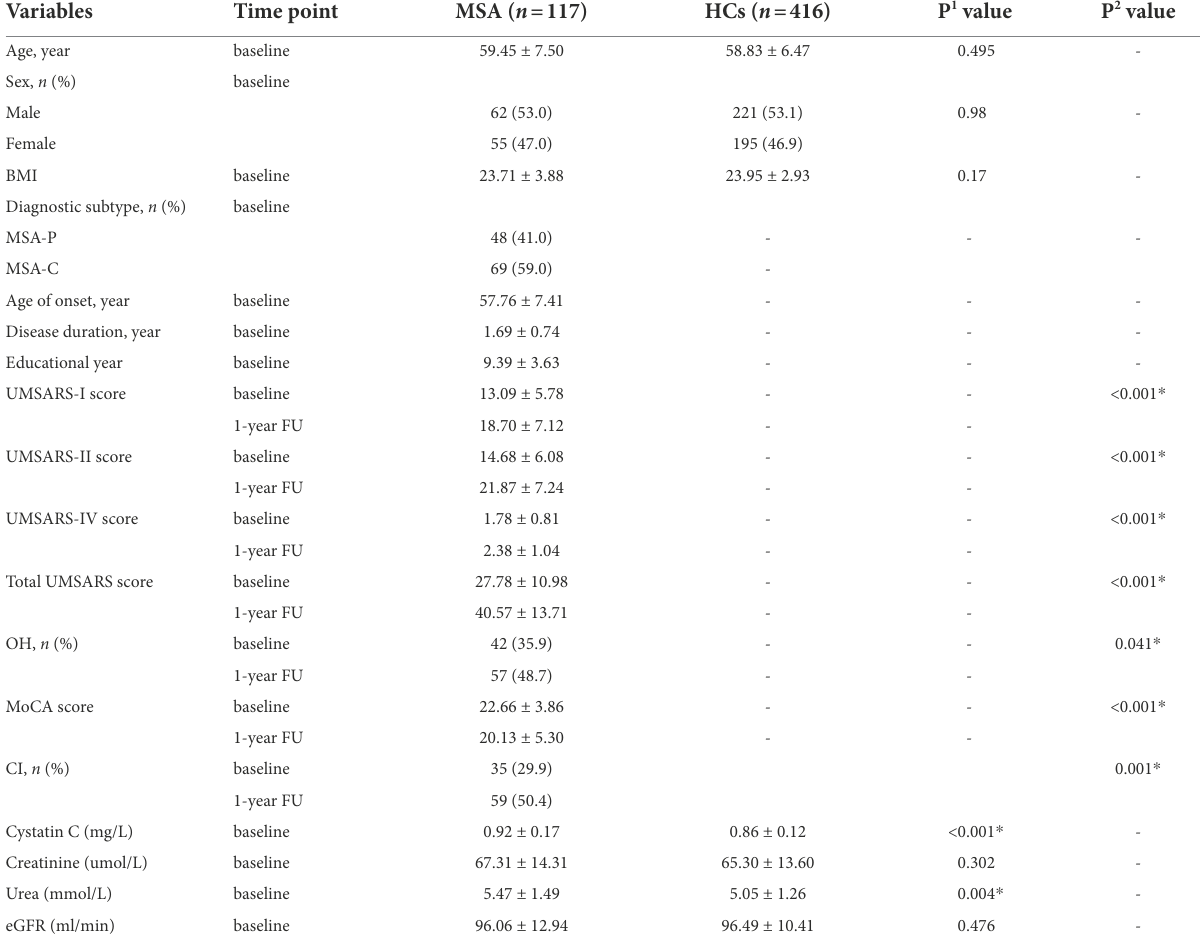
TABLE 1 Demographic and clinical information for MSA and